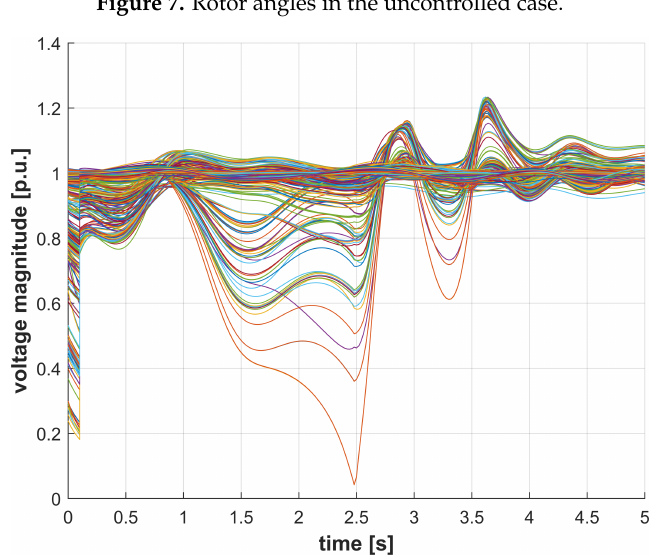
Figure 8. Voltage magnitudes in the uncontrolled case.